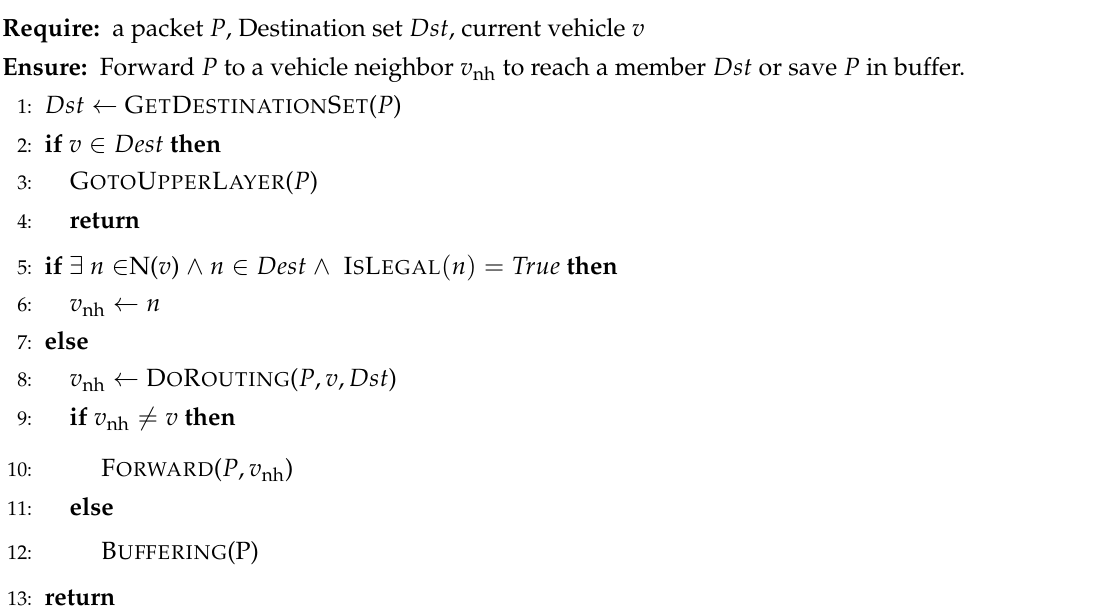
Algorithm 1 General routing process of a DTN geographical